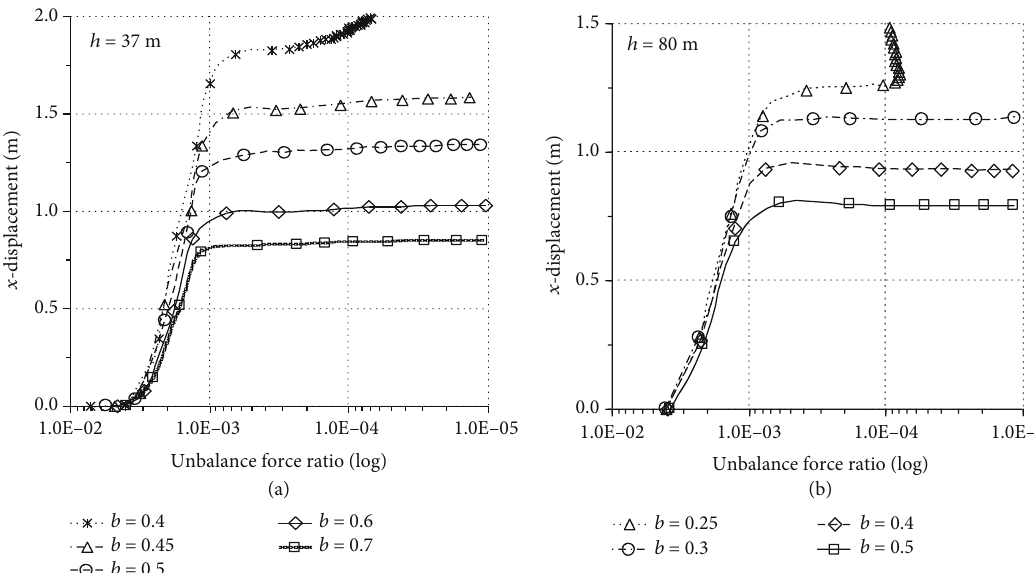
Figure 10: Relationship between x -displacement of node O and unbalanced force rate with di ff erent b